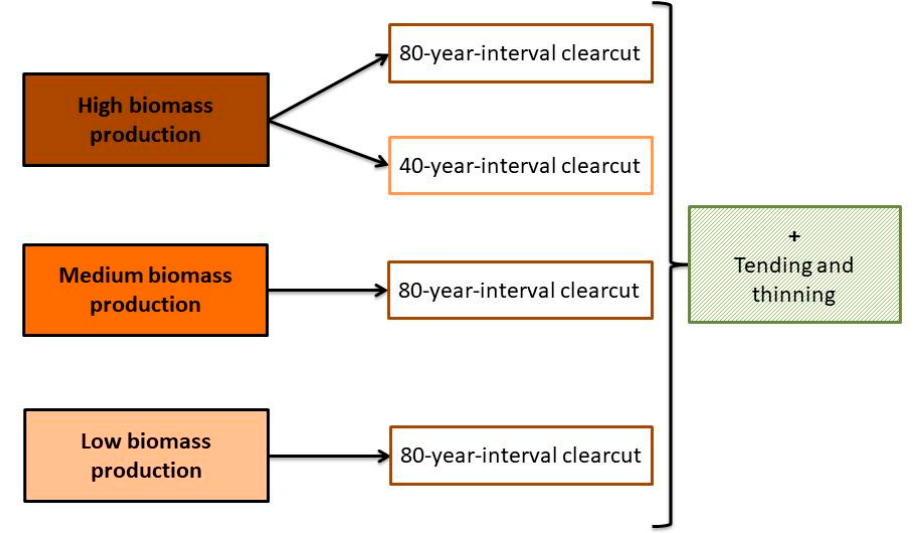
Figure 5. Suggested management practices in South Korean forests based on the amount of soil organic carbon accumulated. carbon